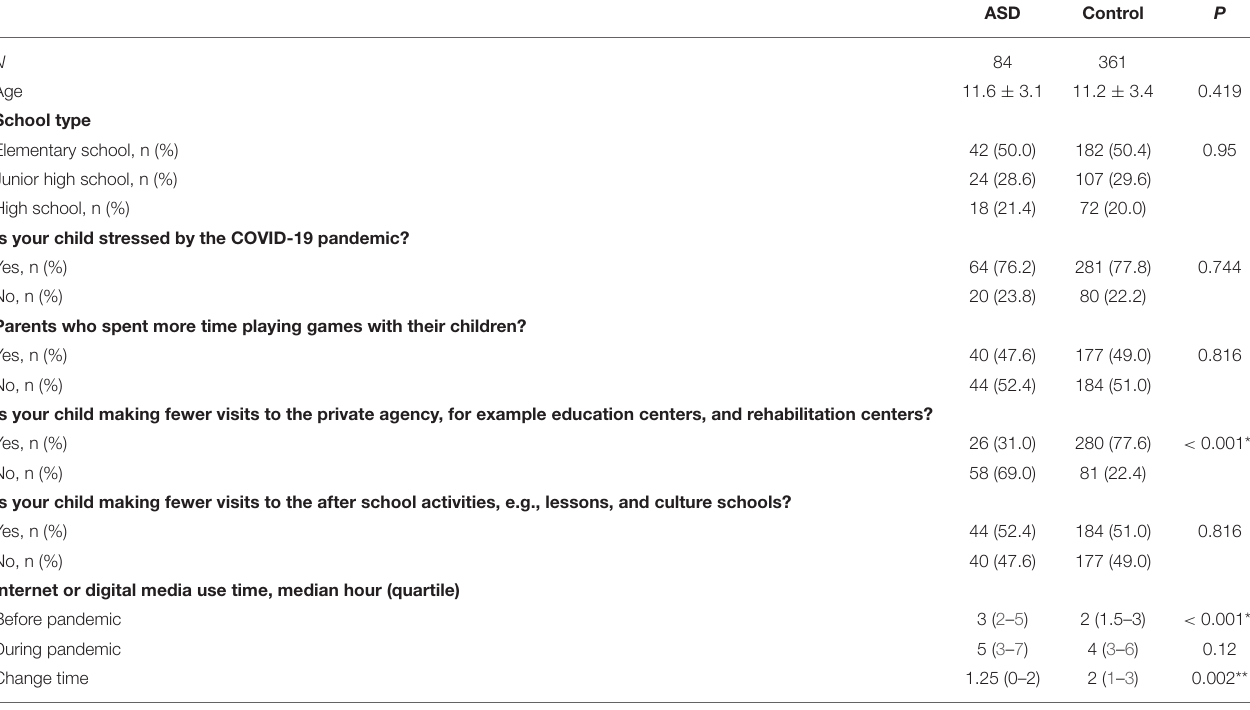
TABLE 2 | Comparison of responses between the autism spectrum disorder and control groups.